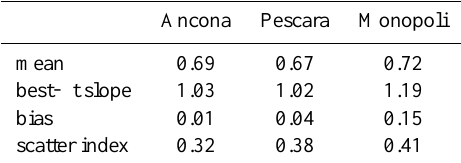
Table 2. As Table 1, but the statistics are now with reference to the data of the wave measuring buoys. See Fig. 3 for their position. Given the irregular availability of the buoy data, the statistics are provided only for the whole